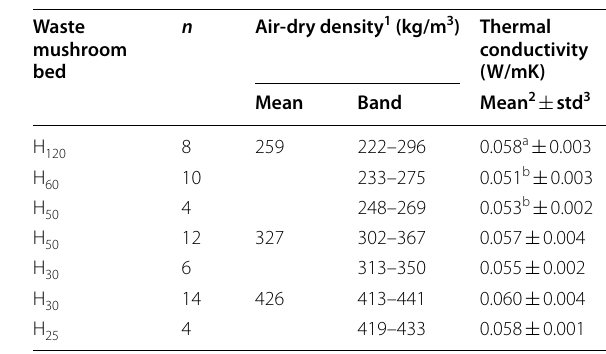
Table 4 Comparison of the thermal conductivity of waste mushroom bed with the same air-dry density